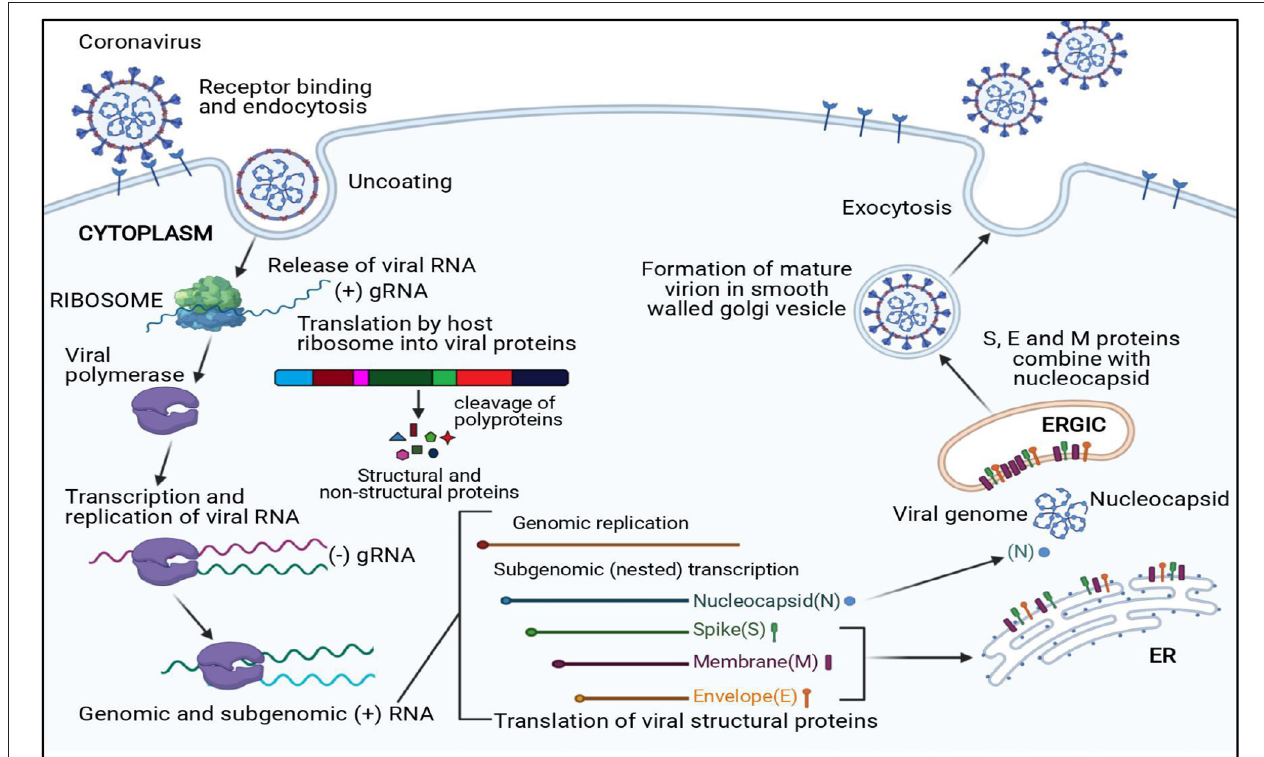
FIGURE 2 | Replication cycle of coronavirus. N, Nucleocapsid; S, Spike protein; M, Membrane protein; E, Envelope protein; ER, Endoplasmic reticulum; ERGIC, Endoplasmic reticulum–Golgi intermediate compartment.